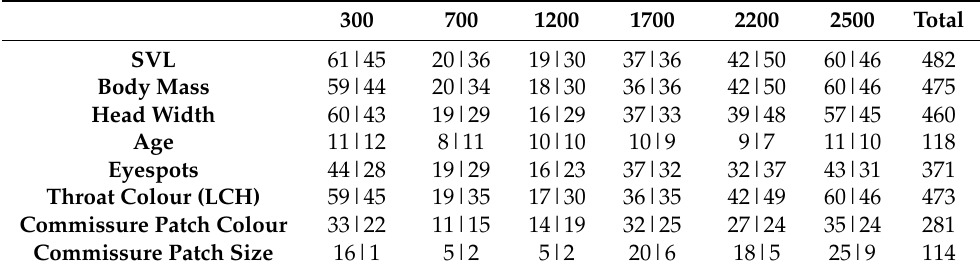
Table A1. Sample sizes per sex (males|females) and per altitude for each variable.